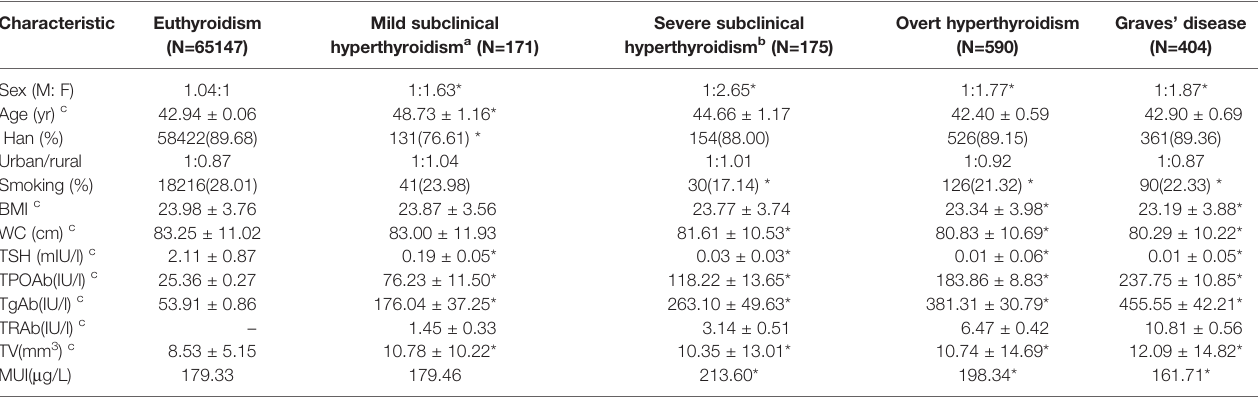
TABLE 1 | Description of clinical parameters in the different thyroid disorder populations. Characteristic Euthyroidism